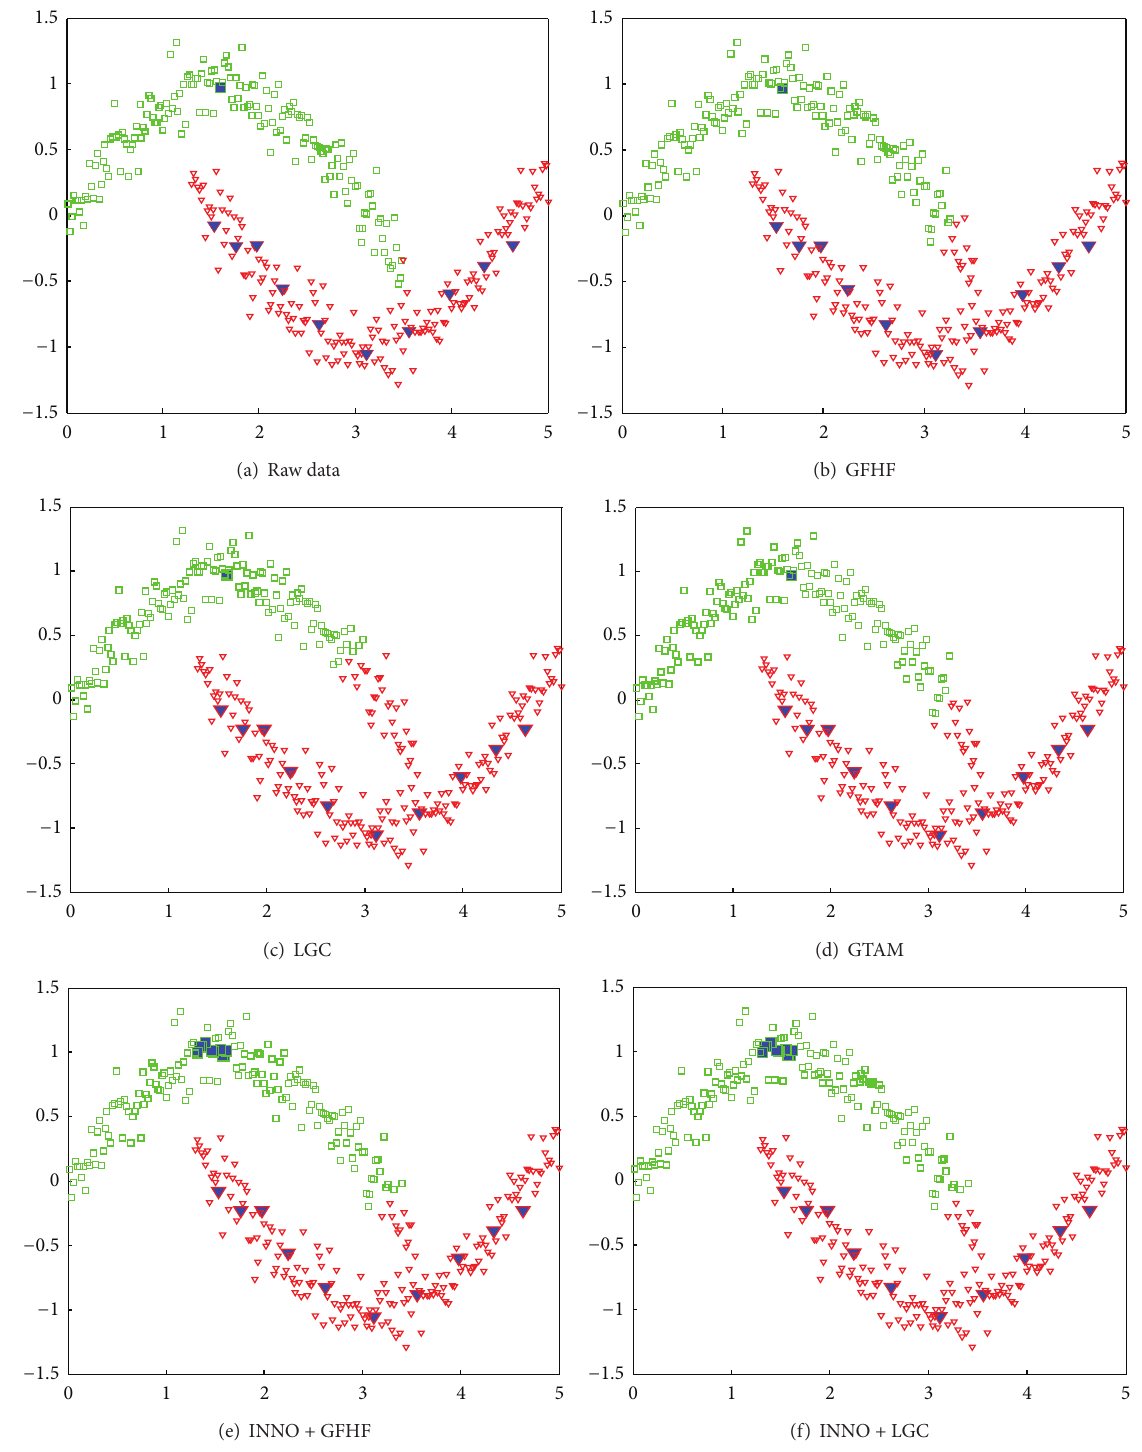
Figure 1: A demonstration of imbalanced label dataset affection to transductive GSSL methods on two-moon toy dataset.